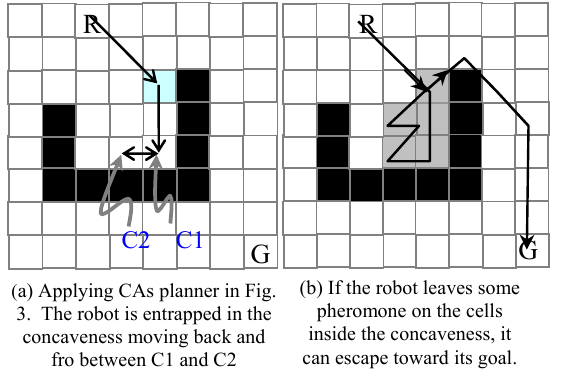
( a) Applying CAs planner in Fig. 3. The robot is entrapped in the concaveness moving back and fro between C1 and Fig. 6. Modification of CAs based planning algorithm for concave obstacles using an ant colony inspired mechanism.